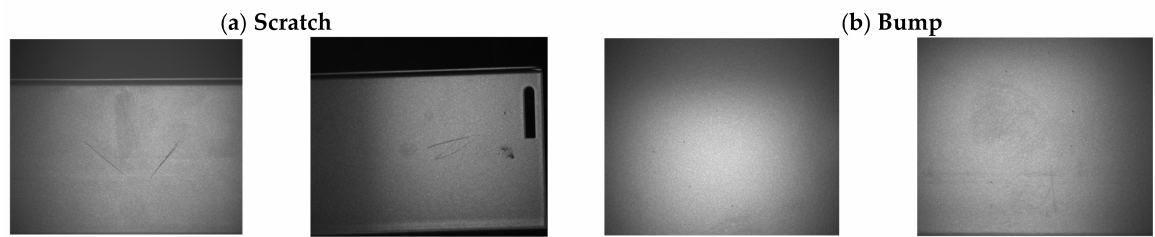
Figure 7. Defect Sample types for Black Color